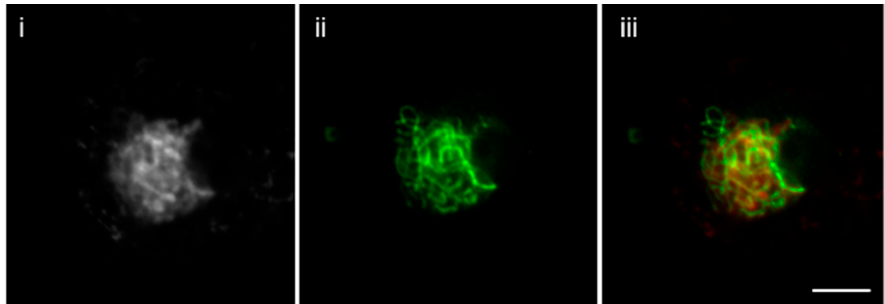
Figure 3. Immunolocalization of ZYP1 in paraformaldehyde-fixed male meiocytes without enzymes. (i) DAPI-stained pachytene chromosome, (ii) ZYP1 stained pachytene chromosome and (iii) Merged. Chromosomes are counterstained with DAPI (left image of each panel); Bar = 10 µ m.